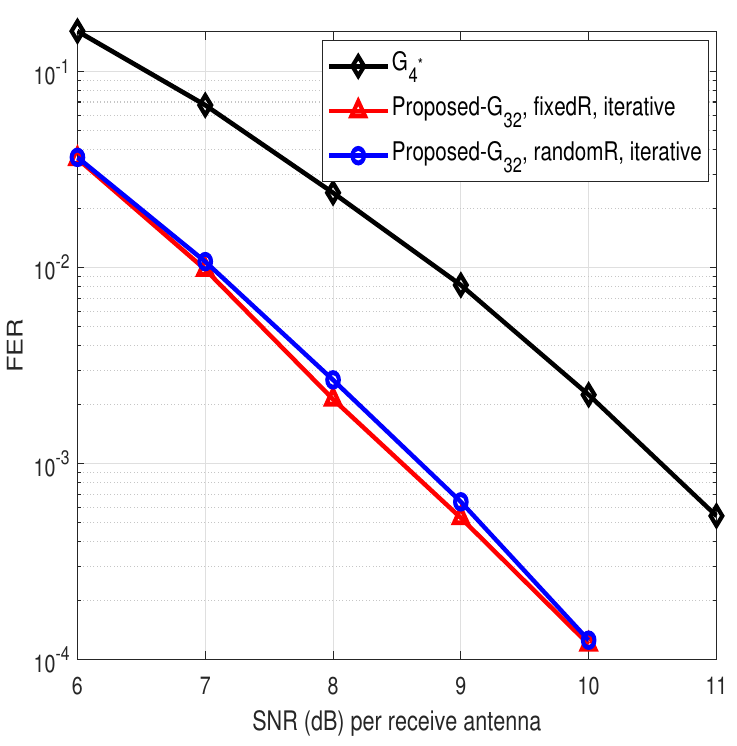
Figure 10. Performance of the proposed scheme based on QPSK − modulated STTC, M T = 2, M R = 2, L = M =